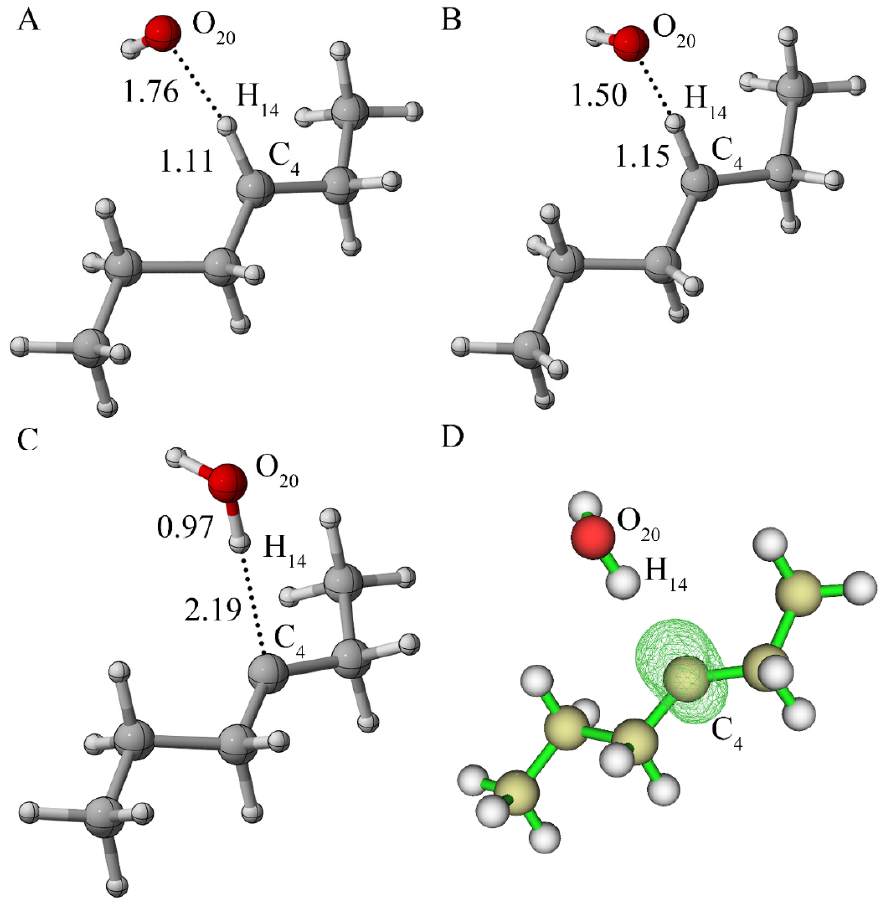
Figure 2. ( A ) Reactants containing an alkane radical and a OH radical; ( B ) transition state; ( C ) prod- ucts; ( D ) spin density of the structure as shown in ( C ) (the value of the iso-surface is 0.01).